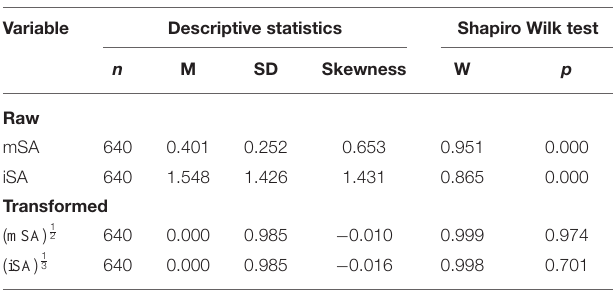
TABLE 1 | Value’s frequencies for independent variables. TABLE 2 | Sample descriptive statistics and normality test of subjective assessment